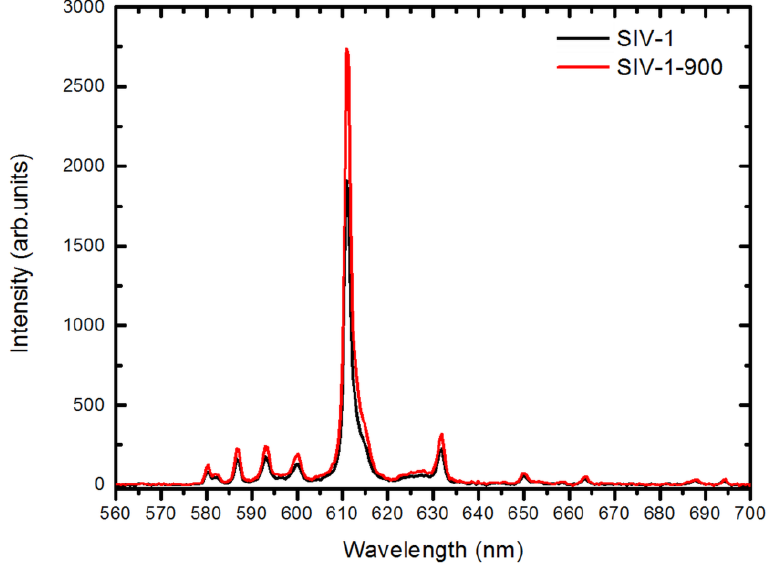
Figure 8. XEL emission spectra of the sample SIV-1 (black line) and SIV-1-900 (red line). See also Table